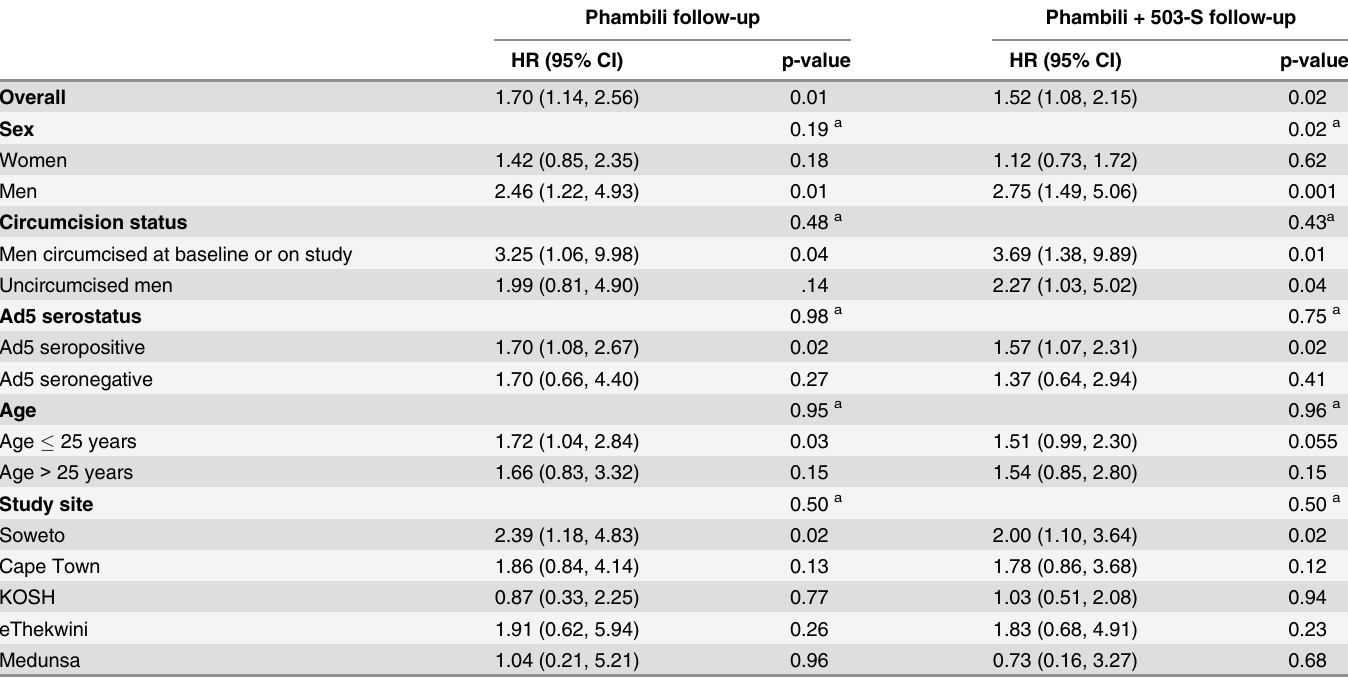
Table 3. Risk of HIV-1 infection (vaccine vs placebo), adjusted for herpes simplex virus 2 status at Phambili enrollment, within